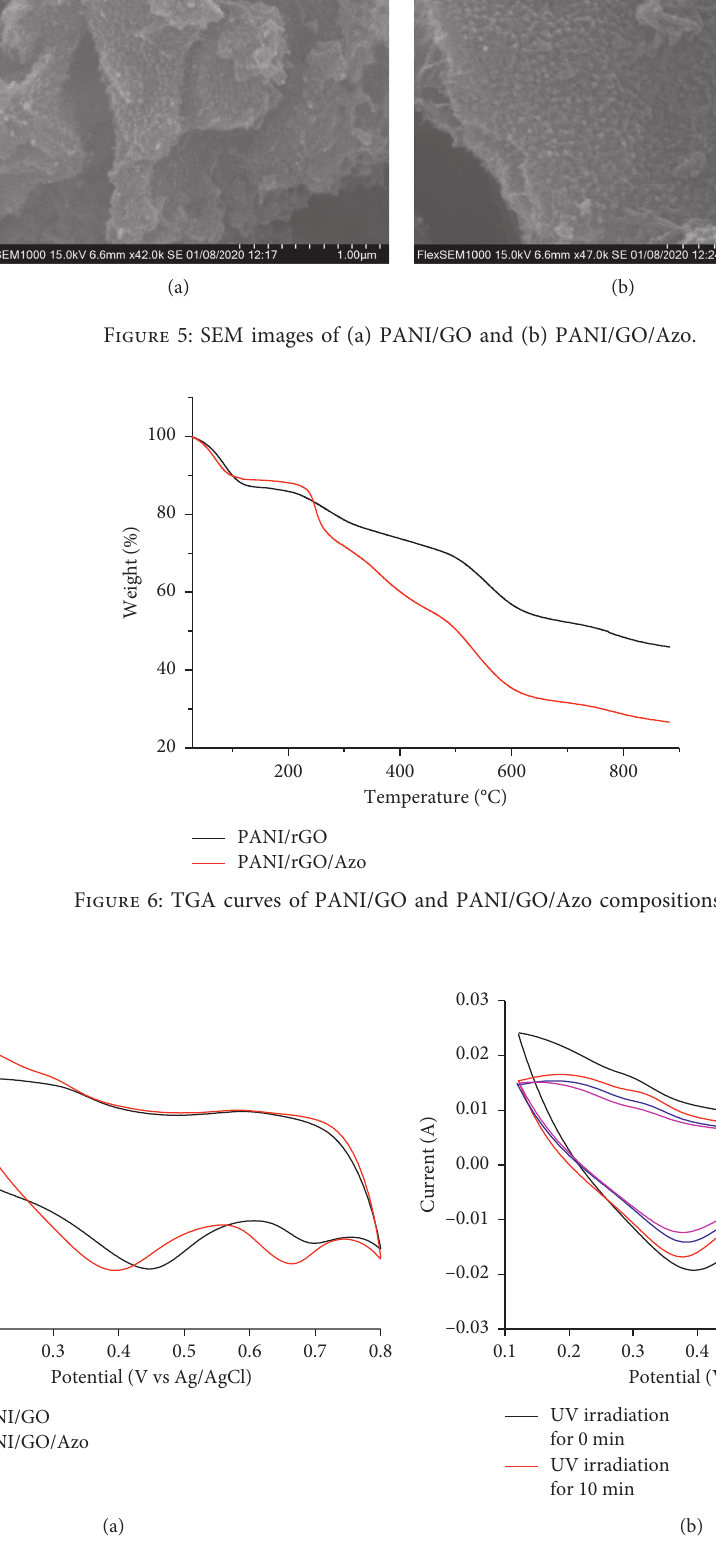
Figure 7: CV curves of (a) PANI/GO and PANI/GO/Azo composites and (b) PANI/GO/Azo composites at different UV irradiation times at a scan rate of